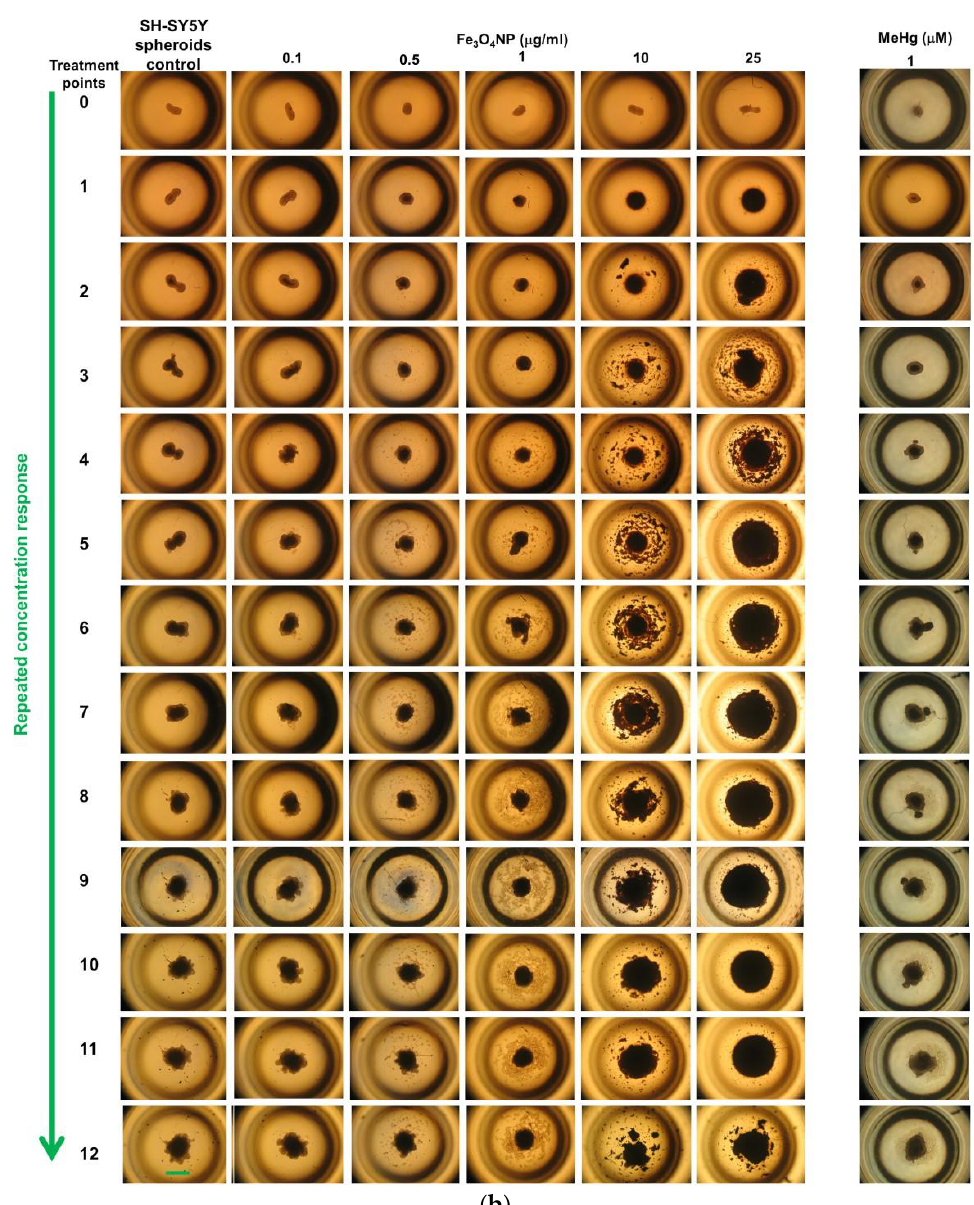
Figure 7. Morphology images in astrocyte and neuronal spheroids after long-term exposure to Fe 3 O 4 NPs: ( a ) Representative images of randomly selected microscopic light-fields of D384 spheroids over time (up to 30 days) with repeated treatment: twelve treatment points, at fixed low Fe 3 O 4 NPs concentrations (0.1; 0.5; 1; 10; 25 μg/mL), for a fixed period of exposure time (30 total days). Cell disaggregation was observed after the first week (i.e., meaning n = 3 repeated fixed concentration) starting from 0.1 μg/mL and became considerably evident at higher concentrations and over time (up to 30 days, corresponding to cumulative total exposures from 1.2 to 300 μg/mL). Scale bar: 600 μm; ( b ) Representative images of randomly selected microscopic light-fields of SH-SY5Y spheroids over time (up to 30 days) with repeated treatment: twelve treatment points, at fixed low Fe 3 O 4 NPs concentrations (0.1; 0.5; 1; 10; 25 μg/mL), for a fixed period of exposure time (30 total days). SH-SY5Y spheroids exhibited strong morphological alterations and lost the compactness of the structure already at the first week starting from 0.1 μg/mL and became evident at higher concentrations and over time (up to 30 days, corresponding to cumulative total exposures from 1.2 to 300 μg/mL). Scale bar: 600 μm.